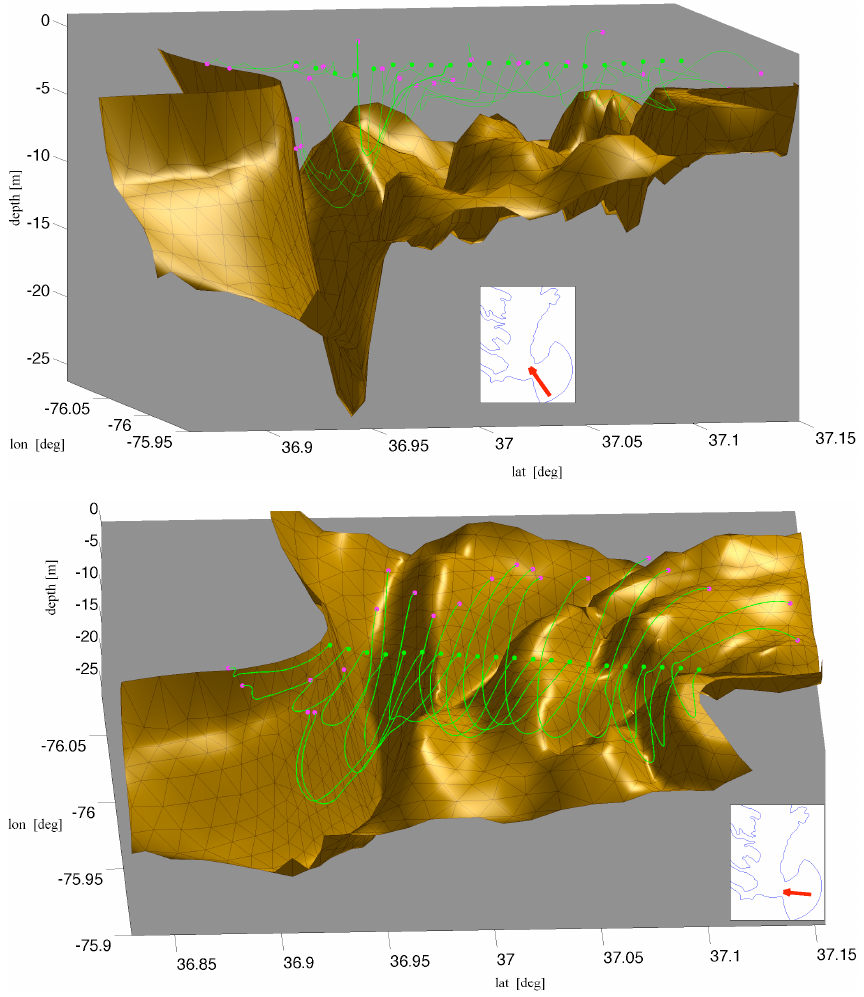
Fig. 4. Example of the 3-D trajectory geometry at the mouth of the Chesapeake Bay; two projections are shown with the point of view indicated by the red arrow in the insets. The trajectories originate in the second sigma level (green dots) and are evolved for 12h; the magenta dots denote the end locations. Note the significant difference in the depth range explored by different trajectories. The horizontal to vertical axes aspect ratios are vastly exaggerated in order to allow a meaningful